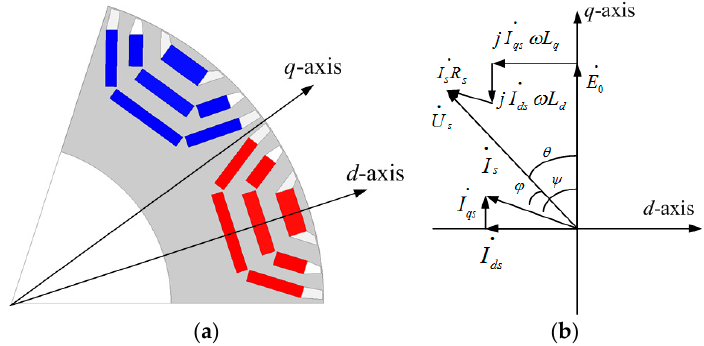
Figure 9. d - q axis and phasor diagram in PMA-SynRM: ( a ) d - q axis definition; ( b ) Phasor diagram. From Figure 9b, the d -axis and q -axis currents can be obtained: sin